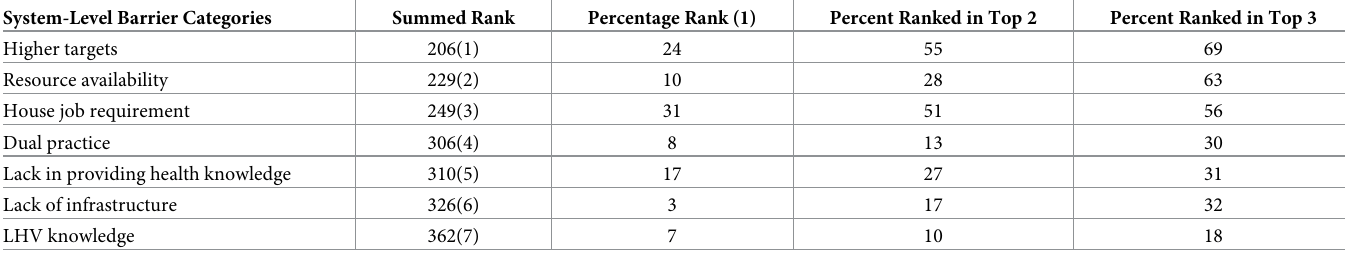
Table 8. Rank orders (system-level